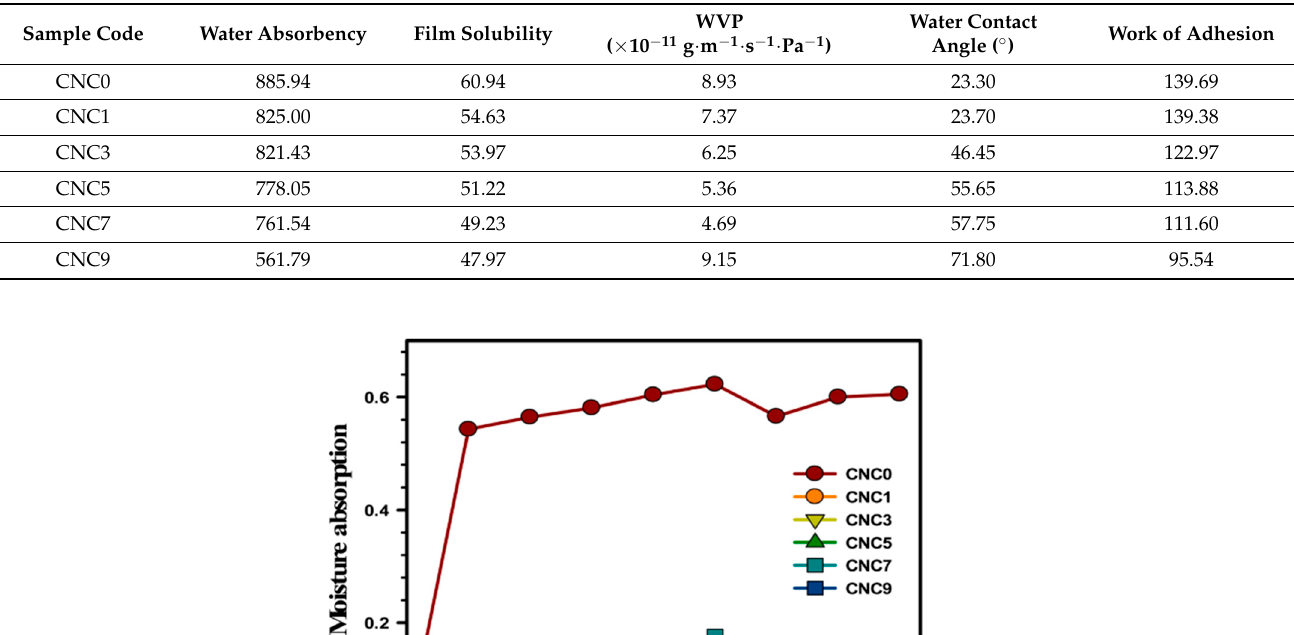
Table 7. Water interactive properties of the kappa-carrageenan/nanocellulose composites at different loading (taken from [36] with permission from Elsevier).